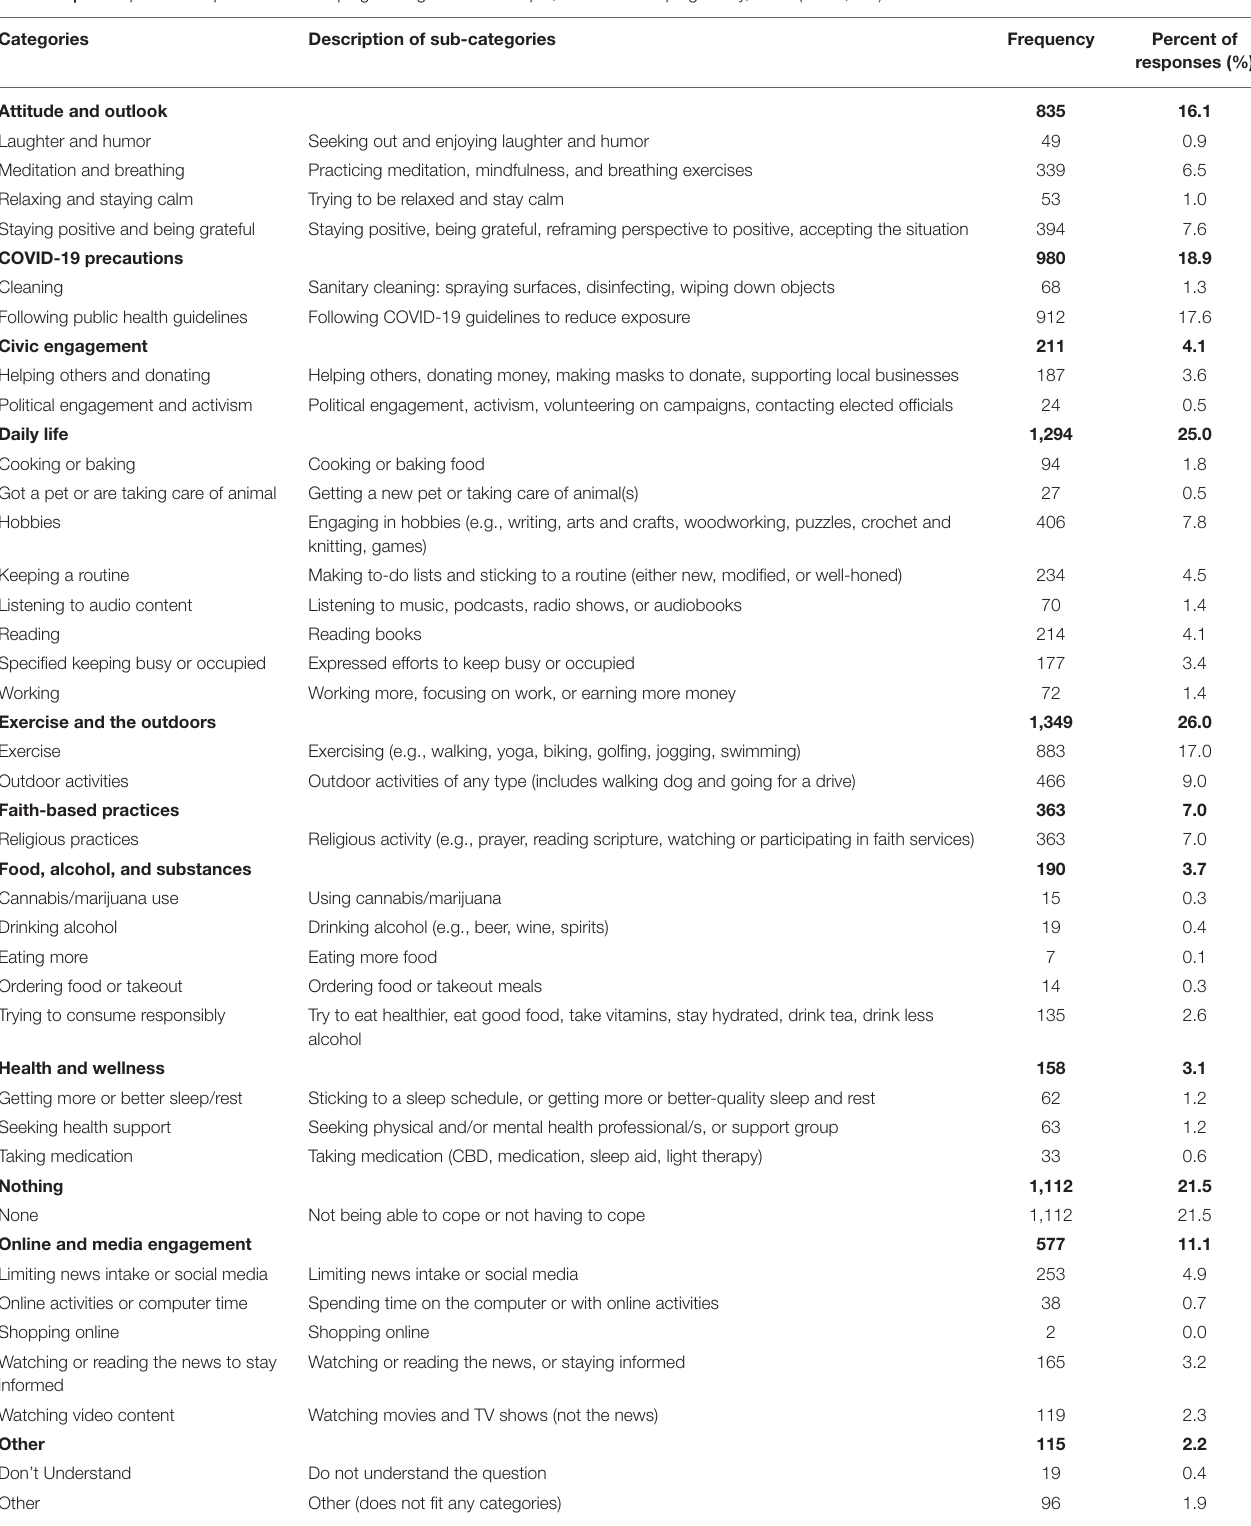
TABLE 2 | Descriptions and prevalence of coping strategies in the sample, COVID-19 Coping Study, 2020 ( n = 5,180).